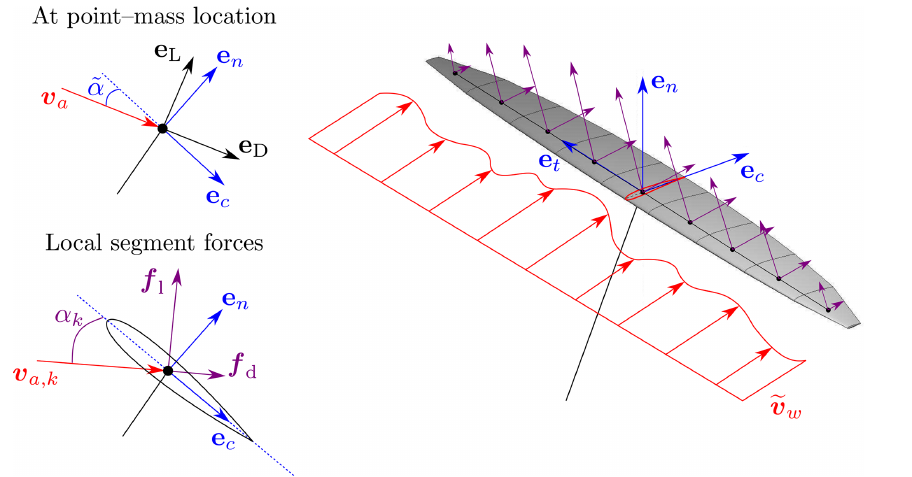
Figure 2. Sketch of the configuration used in the lifting line model, showing the orientation of the AWE wing B = { e c , e t , e n } with respect to the incoming wind field (cid:101) v w and the aerodynamic forces f l and f d acting on the wing sections for a given apparent wind speed v a ,k